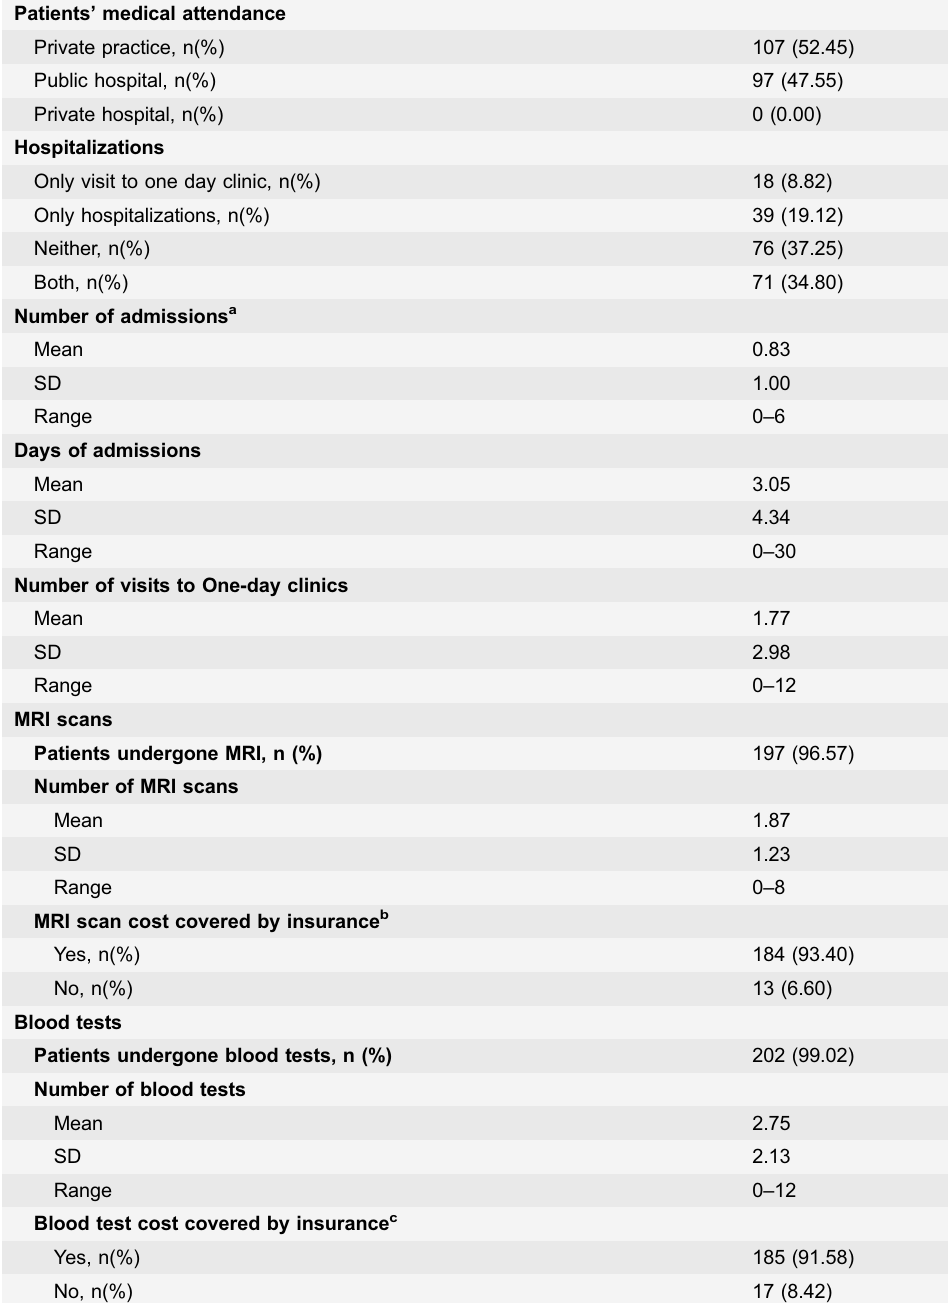
Table 2. Patients’ medical attendance, hospitalization and laboratory requirements of the studied population (n 5